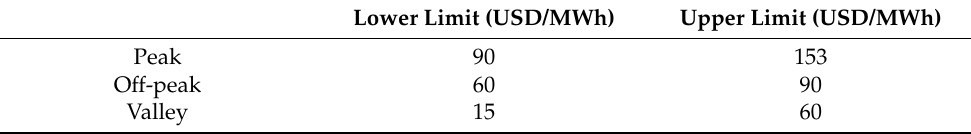
Table 2. Constraint of TOU electricity